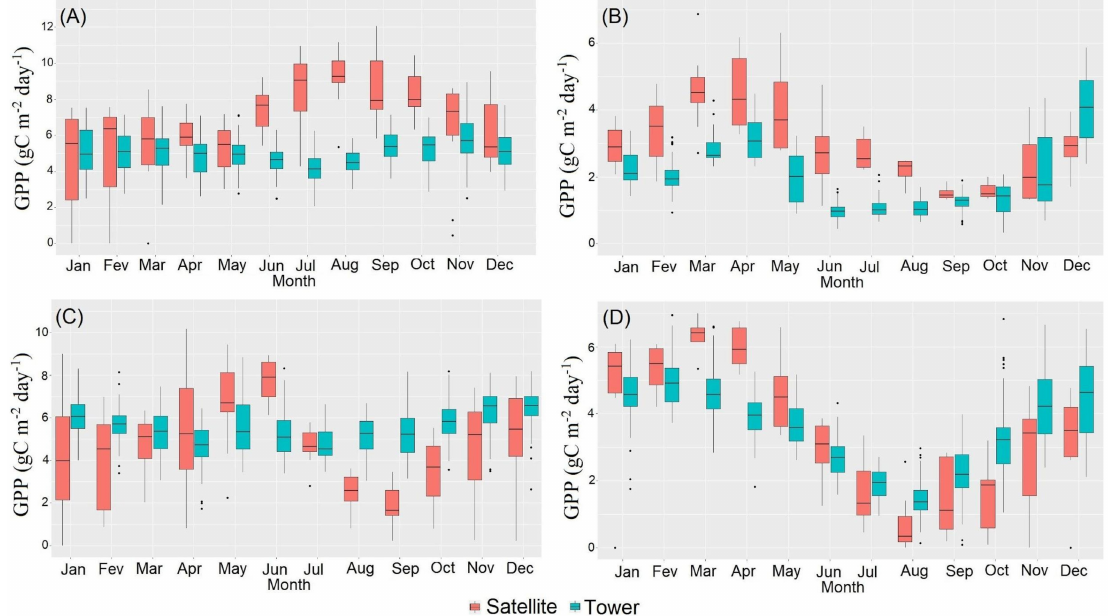
Figure 9. Monthly GPP boxplot (gC m − 2 day − 1 ) for eddy covariance observed data (Tower) and MODIS—derived data (Satellite) for the: ( A ) Amazonia; ( B ) Caatinga; ( C ) Cerrado; ( D ) Pantanal sites.